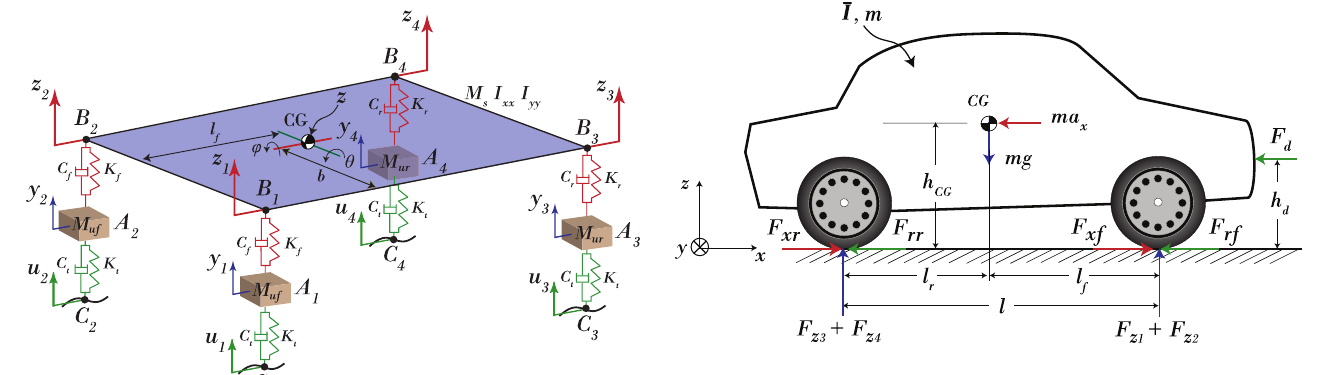
Fig. 4. Longitudinal dynamics of the